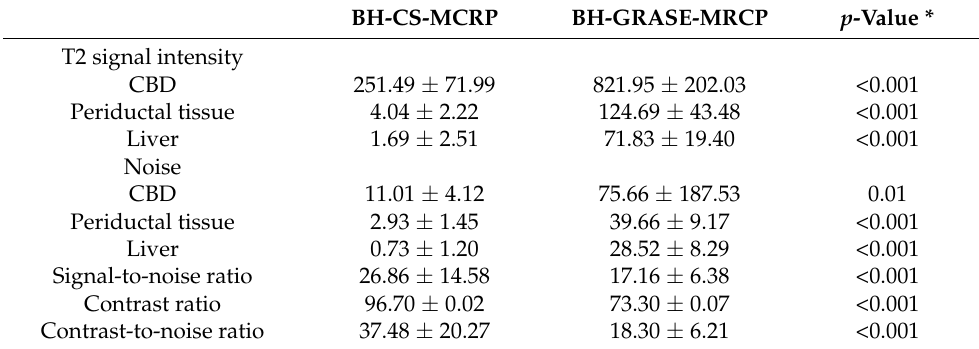
Table 4. Results of quantitative